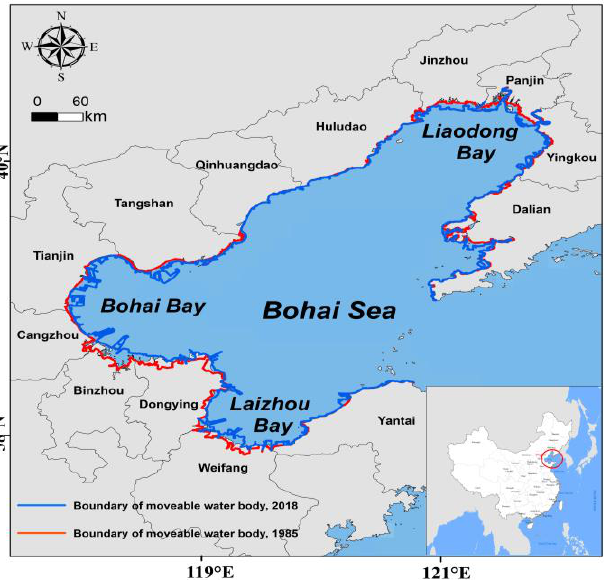
Figure 2. Location and change in boundary of movable water bodies of the study area.